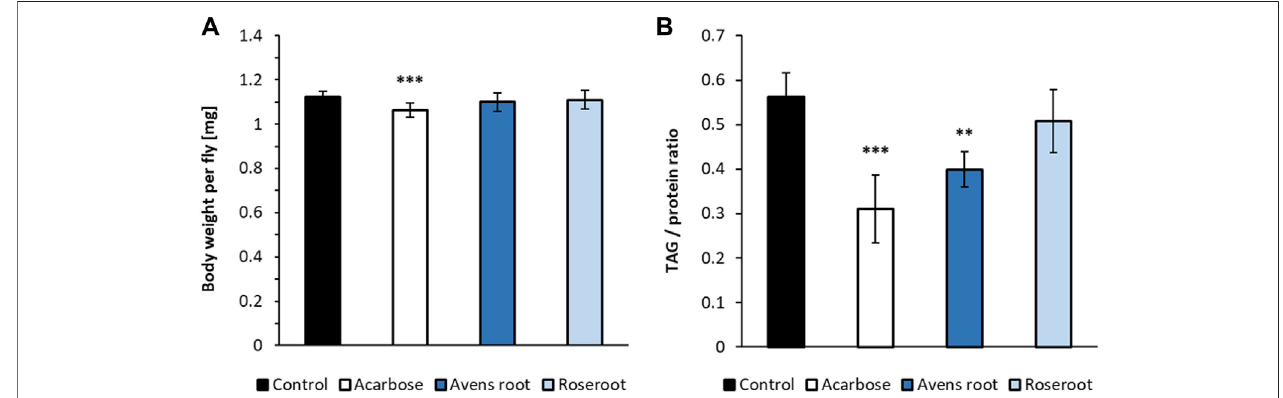
FIGURE 6 | The impact of root extracts on body weight and lipid storage in D. melanogaster . Female D. melanogaster were raised on a 10% starch, 4% yeast extract dietsupplemented with 1.8 μ g/ml acarbose, 2.5%avens rootand 2.5%roseroot extract, respectively. The body weights (A) and triglyceride toprotein ratios (B) were determined on day 10 after eclosion and compared to the respective values for fl ies fed a control diet without supplement. Bars represent the mean ± standard deviation of three independent experiments performed in triplicate. Statistical analysis was carried out by using one-way ANOVA followed by Dunnett ’ s multiple comparisons test (** p < 0.01; *** p < 0.001).